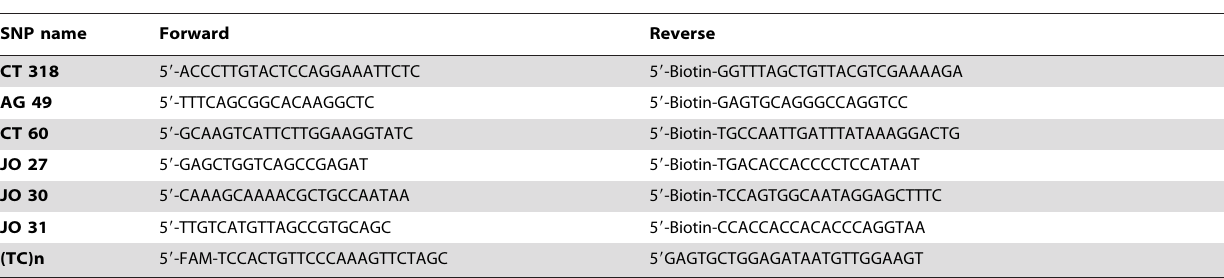
Table 1. PCR Primers for FOXP3 (TC)n